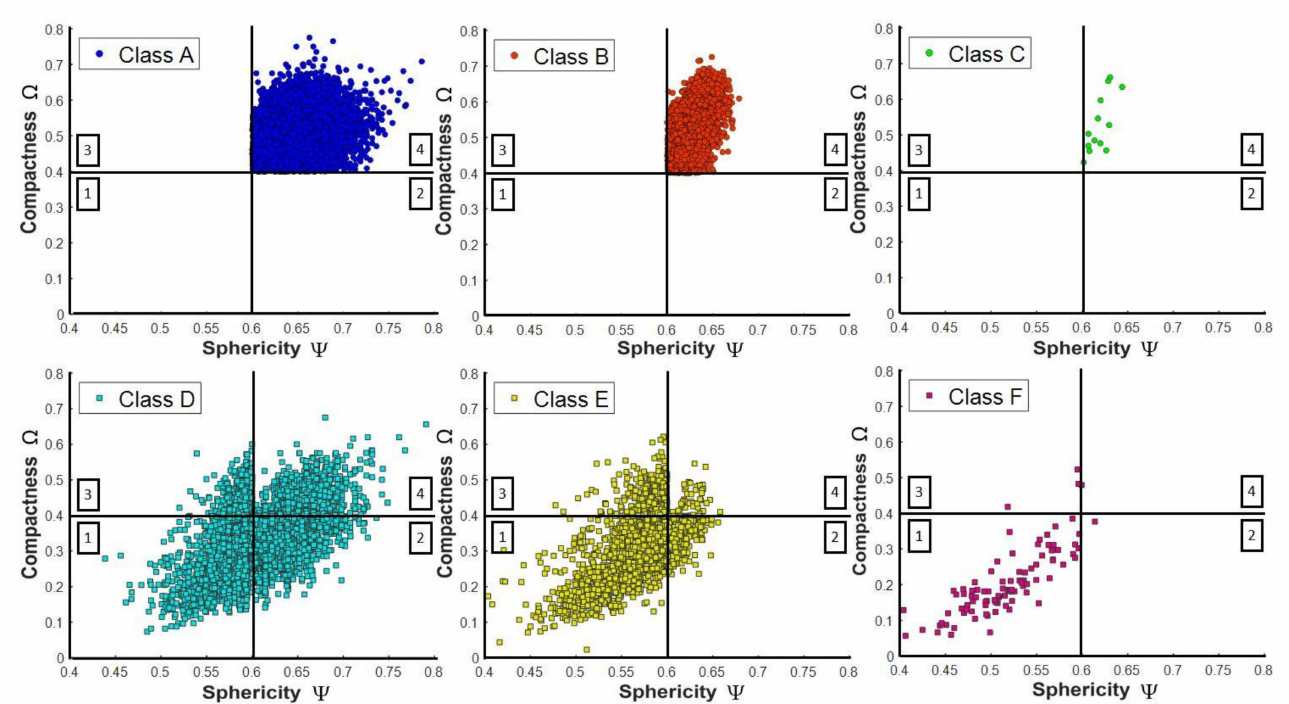
Figure 5. Pore classification of a scanned cylindrical specimen fabricated by laser powder bed fusion (details in Section 2.1). The corresponding classification areas 1, 2, 3, and 4 are according to the sphericity and compactness criteria of Table 2.